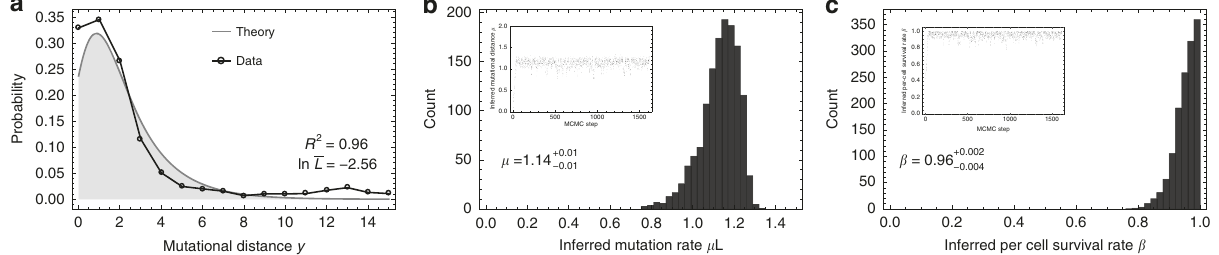
Fig. 3 Per-cell mutation and per-cell survival rate inferences in healthy haematopoiesis during development. a Mutational distance distribution inferred from 89 whole-genome sequenced healthy haematopoietic stem cells from ref. 13 (black dots), and best theoretical fi t (grey line). Posterior parameter distribution of the MCMC inference for b the mutation rate per cell division ( μ L ¼ 1 : 14 þ 0 : 12 (cid:2) mutations per genome per cell division) and c the cell survival 0 : 24 rate ( β ¼ 0 : 96 þ 0 : 038 (cid:2) ). Median point estimates and 95% credibility intervals were taken from the posterior parameter distributions. The inferred mutation 0 : 102 rate per cell division agrees with the original estimation of 1.2 mutations per cell division. Furthermore, our joined inference of mutation and cell survival rate con fi rms the original assumption of no cell death during early development of a fi xed set of parameters (Supplementary Fig. 17). In Fig. 3a, b we show the posterior parameter distributions after an initial burn in